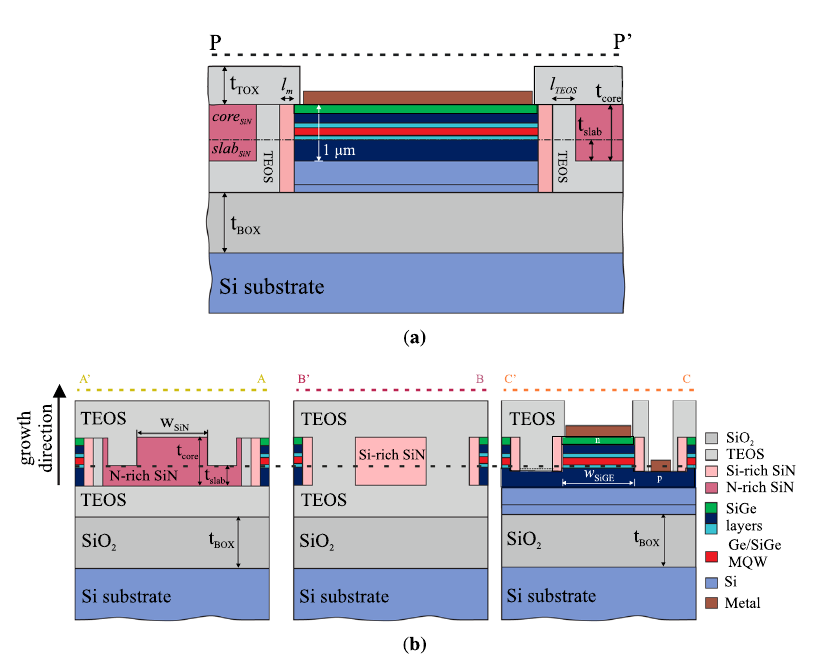
Figure 9. SiN-to-MQW butt-coupling interconnection concept. The PP’ dashed line reveals the side view of the structure depicted in (a) . The MQW stack stands in the middle and its facets are connected to the N-rich SiN waveguides. Cross-sections of the separate elements of the structure are disclosed in (b) . The cuts AA’ and CC’ reflect to the N-rich SiN and the MQW SiGe-stack, respectively. BB’ refers to the Si-rich SiN layer that is set, along with the TEOS layer, between the two waveguides towards optimal photonic coupling. All the materials are described in the colormap of (b)